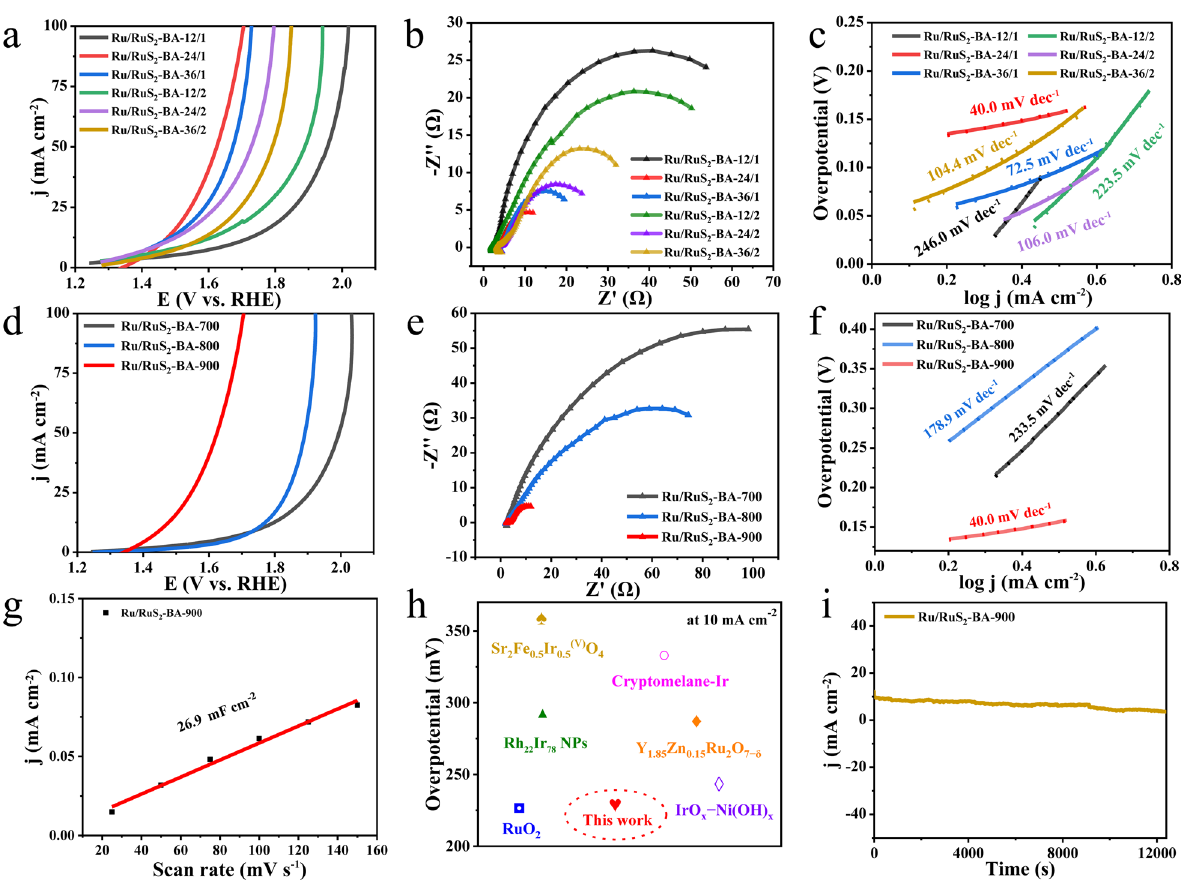
Fig. 5 a OER polarization curves, b EIS Nyquist plots, and c Tafel plots of Ru/RuS 2 -BA with different mass ratios in 0.5 M H 2 SO 4 . d OER polarization curves, e EIS Nyquist plots, and f Tafel plots of Ru/ RuS 2 -BA with different carbonization temperature in 0.5 M H 2 SO 4 .